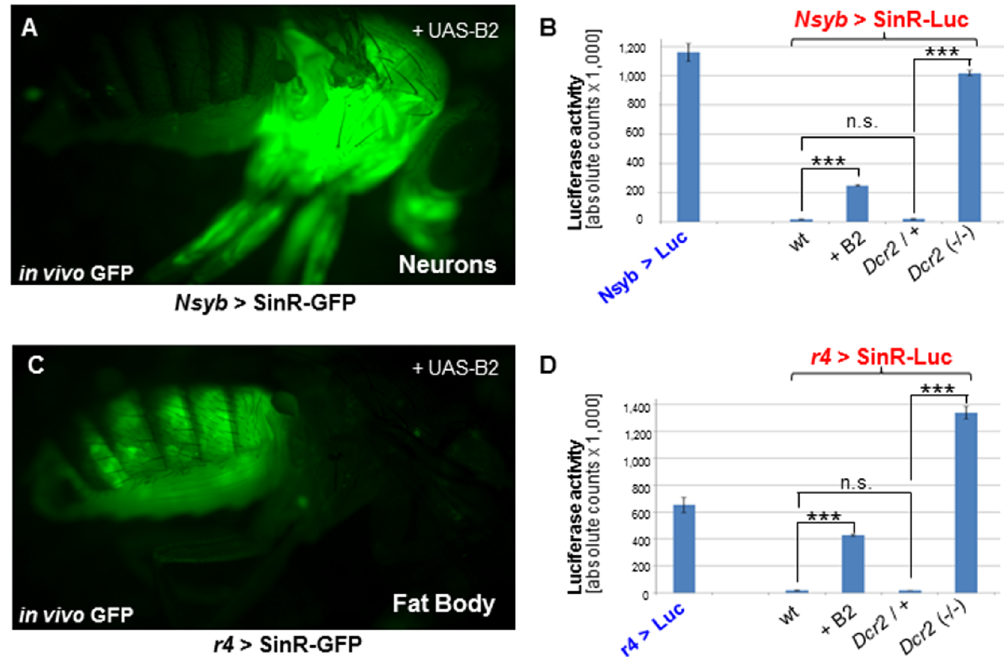
Figure 3. Quantification of Sindbis replicon expression in different tissues. A,C. Examples of SinR-GFP expression in different tissues. Labeled are adult neurons ( NSyb -GAL4; A) or adult fat body ( r4 -GAL4; C). For both tissues, RNAi was inhibited using UAS-B2. B. Quantification of SinR- Luc Luciferase activity in neurons. Significantly higher levels of Luciferase activity were obtained in homozygous Dcr2 mutants, comparable to those obtained with UAS-Luciferase controls. Inactivation of RNAi using UAS-B2 had weaker yet comparable effects while Drc2 heterozygotes show little to no effect. D. Similar effects were obtained in other tissues, like the adult fat body). All luminometer counts in relative units per fly, per uL of